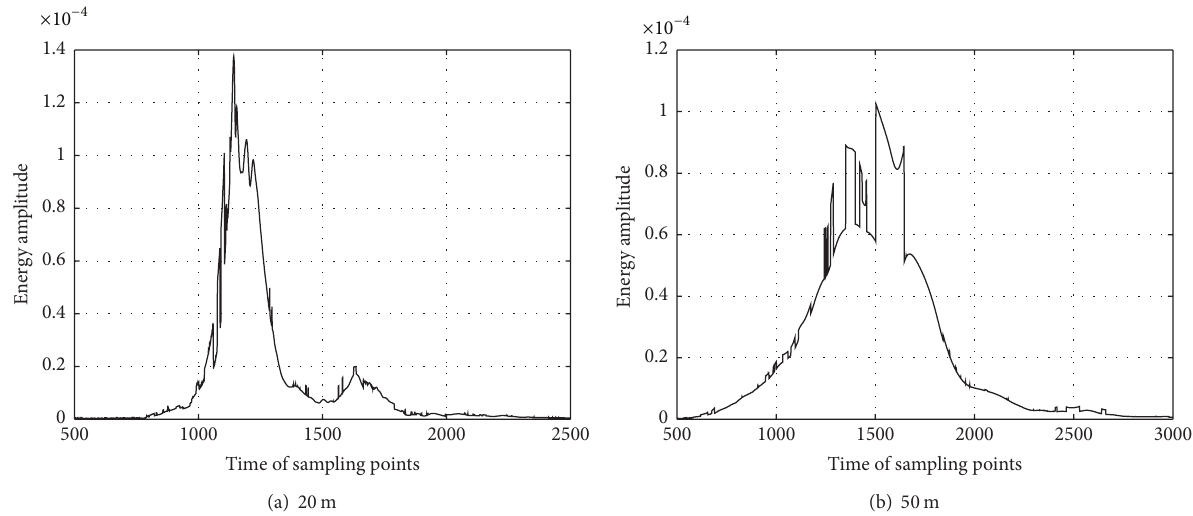
Figure 15: Instantaneous energy graph of vibration signals at different measuring